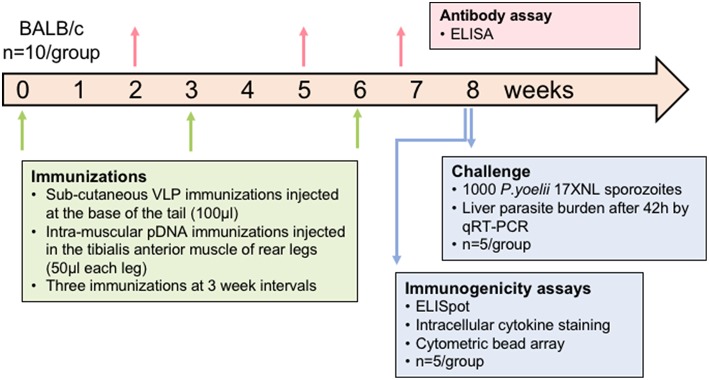
Schematic of experimental design. In each experiment, mice (n = 10/group) were immunized three times at a 3-week interval. Plasmid DNA injections were intramuscular into the tibialis anterior whilst VLP immunizations were subcutaneous on the back near the base of the tail. Blood samples were collected 14 days after doses 1 and 2 and then 5 days after the final dose to assess antibody responses. Half of the mice were euthanized at 10 days after the final dose and splenocytes used for immunogenicity assays. The other half were challenged 2 weeks after the final dose by injecting 1,000 P. yoelii sporozoites into a tail vein, and livers removed 42 h later to assess parasite load by qRT-PCR. In one experiment, the VLP doses were 30 μg for individual VLPs or 10 μg of each in the pooled VLP group. In another experiment, the pooled VLP dose was increased to 30 μg of each VLP and a DNA-only control was included.